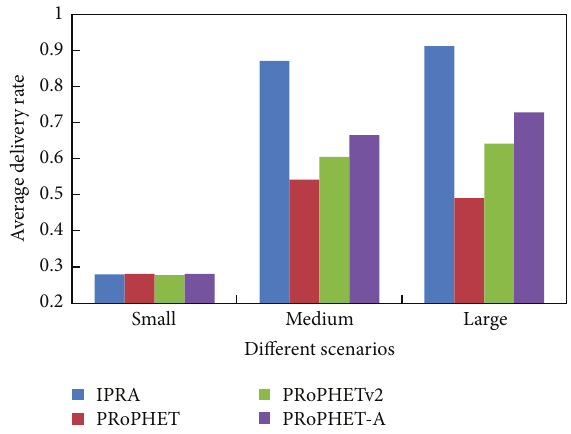
Figure 12: Average delay (AD) versus message lifetime.